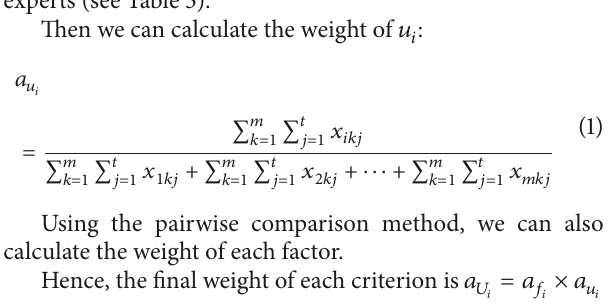
(𝑛 = 1, 2, 3, 4) is 𝑗𝑛